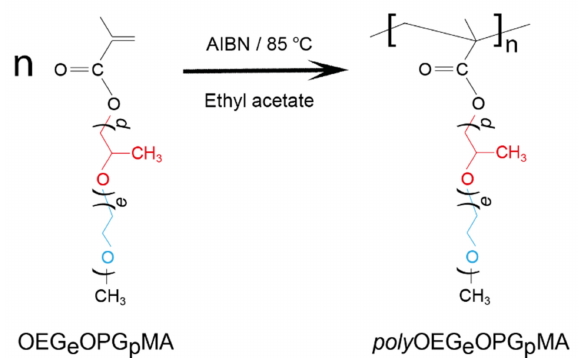
Figure 1. Structures of the studied polymer